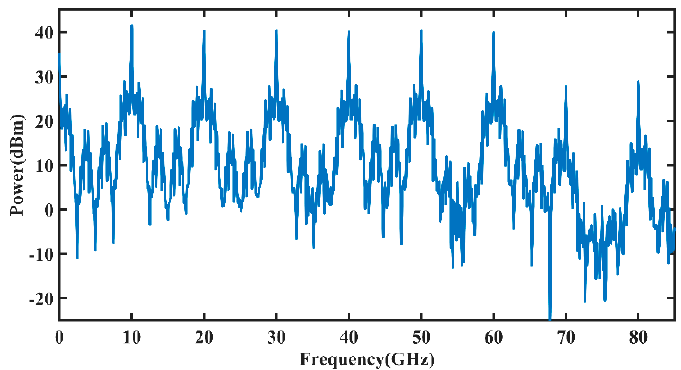
Figure 2. The spectrum of ASK signal at eight wavebands.